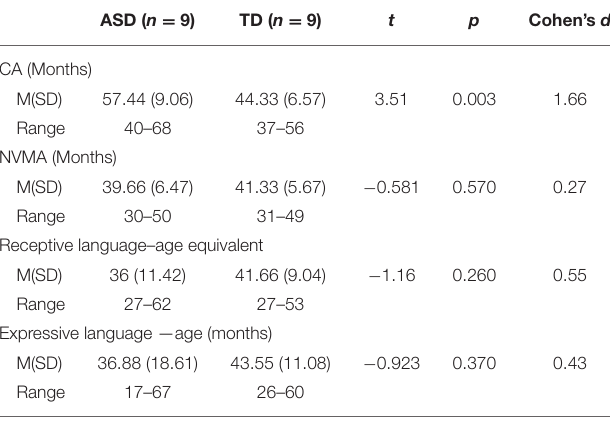
TABLE 3 | Performance of typically developing and autism spectrum disorder groups on the reverse categorization and the dimensional change card sort tasks. Task Group